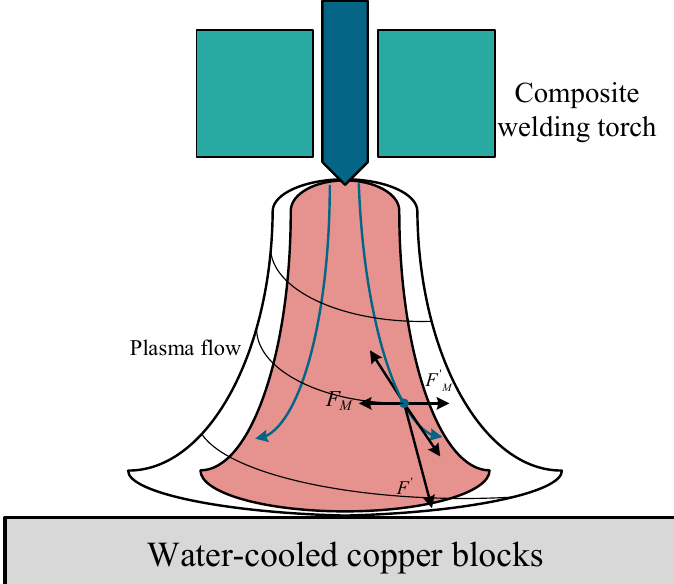
Figure 10. U-M-GTAW arc force